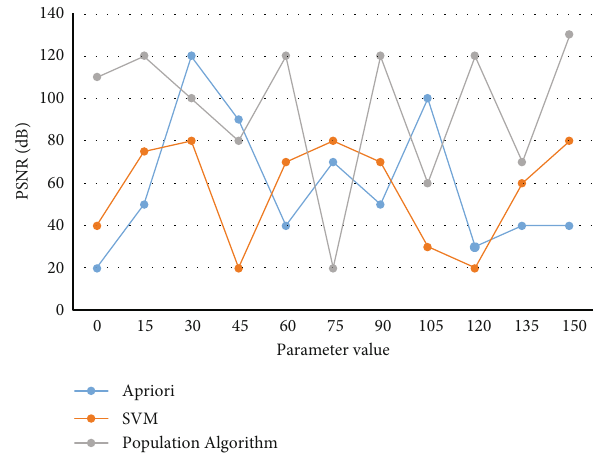
Figure 7: Simulation comparison of three di ff erent algorithms.